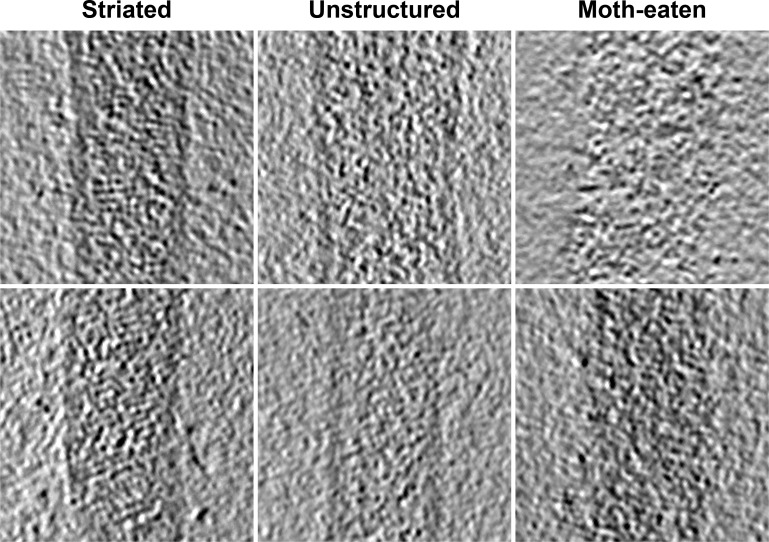
Tomographic slices of Ebola virus matrix layers.Left column shows regions that show ordered VP40 striations, center column shows virions with intact membranes but unstructured matrix layer, and right column shows matrix layer of moth-eaten membranes.